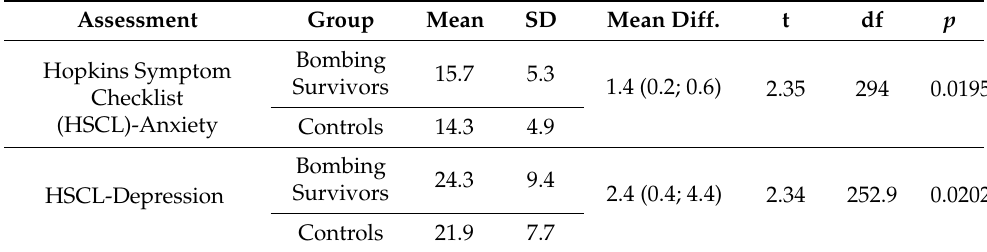
Table 1. Anxiety and Depression Symptoms in Survivors and Controls.